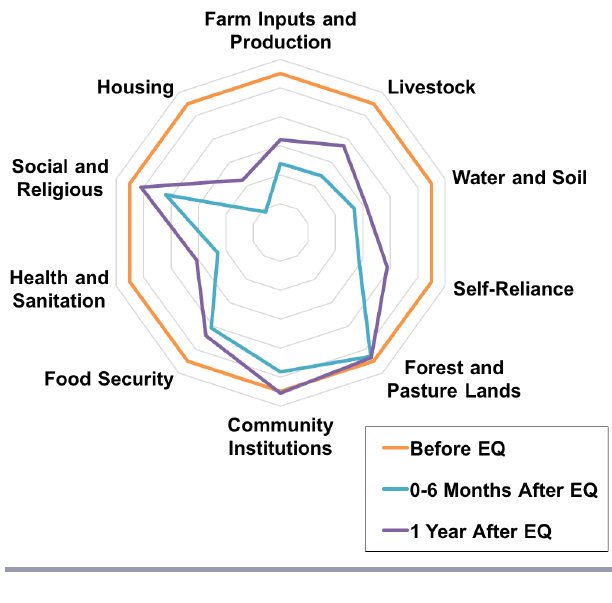
Fig. 3 . Spider diagram of earthquake (EQ) impacts to all 10 adaptation and recovery assessment indicators (Table 1). Scores for individual metrics are averaged across total respondents (n = 79). The outer edge represents the self-assessed pre- earthquake baseline. The closer to the center an indicator falls, the more an indicator declined relative to the pre-earthquake baseline; the closer it is to the outer edge, the more an indicator recovered.